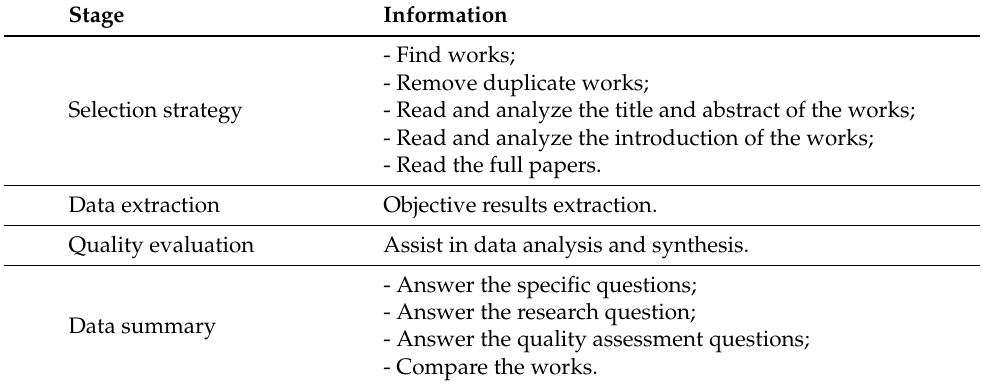
Table 5. SLR protocol: selection and analysis of primary studies.